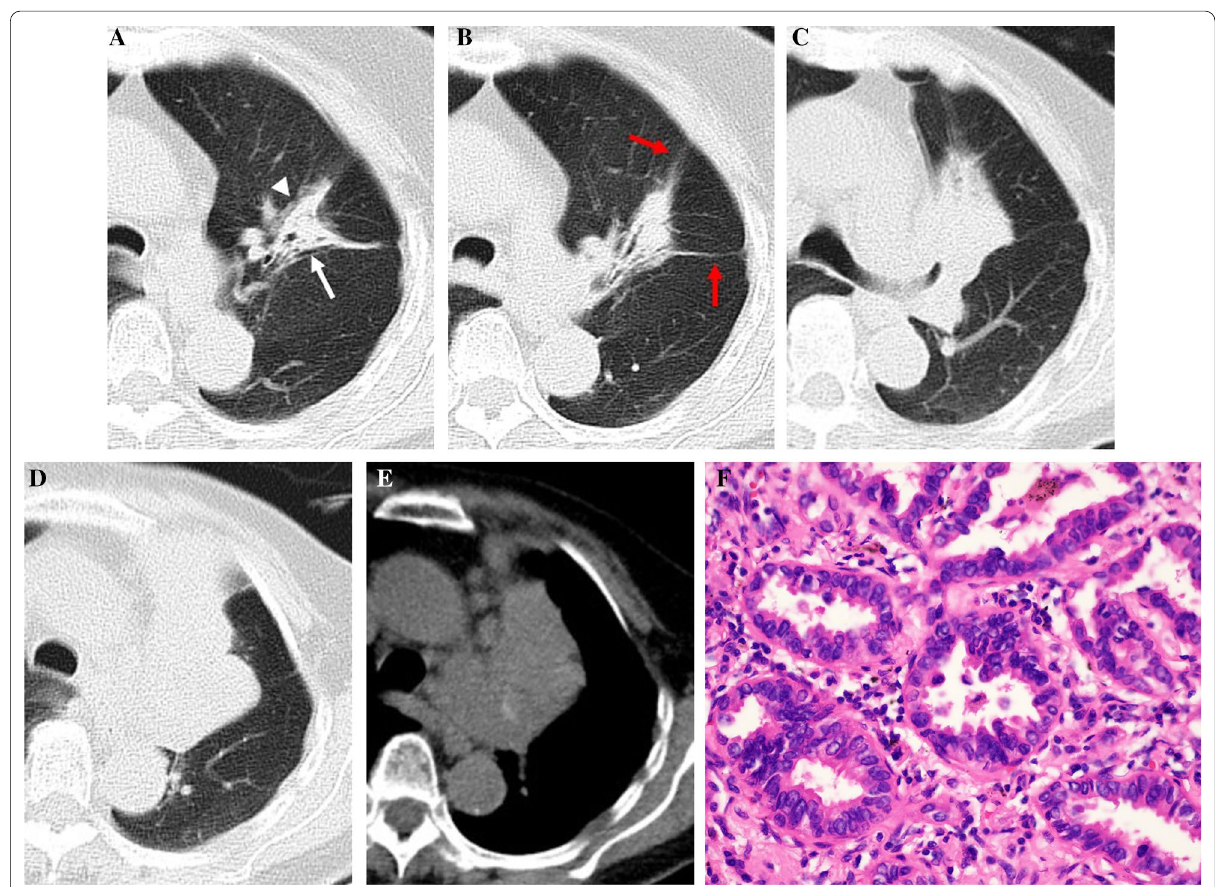
Fig. 2 L‑PLADC in an 83‑year‑old woman without symptoms. A and B Axial CT images of lung window indicate a localized consolidation with irregular air bronchogram (white arrow), GGO component (white arrowhead), and pleural retraction (red arrow) in the left upper lobe. This patient was misdiagnosed as inflammatory lesion and did not receive further examination. C – E Thirty‑eight months later, follow‑up CT scan shows a hilar mass in the left upper lobe with mediastinal lymphadenopathy. F Photomicrograph (hematoxylin and eosin staining, an acinar‑predominant pattern